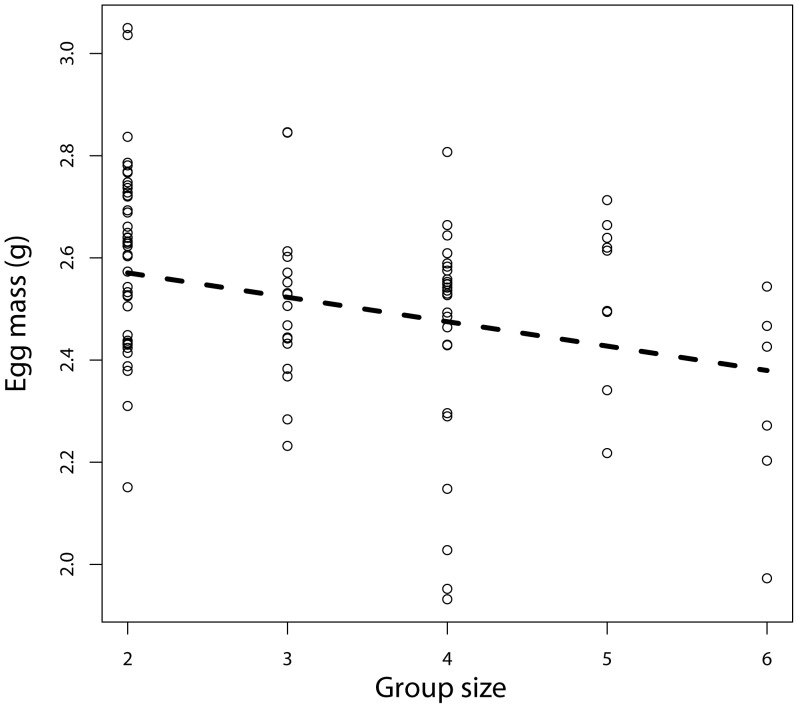
Egg mass decreased in relation to breeding group size.The line indicates the predicted values.